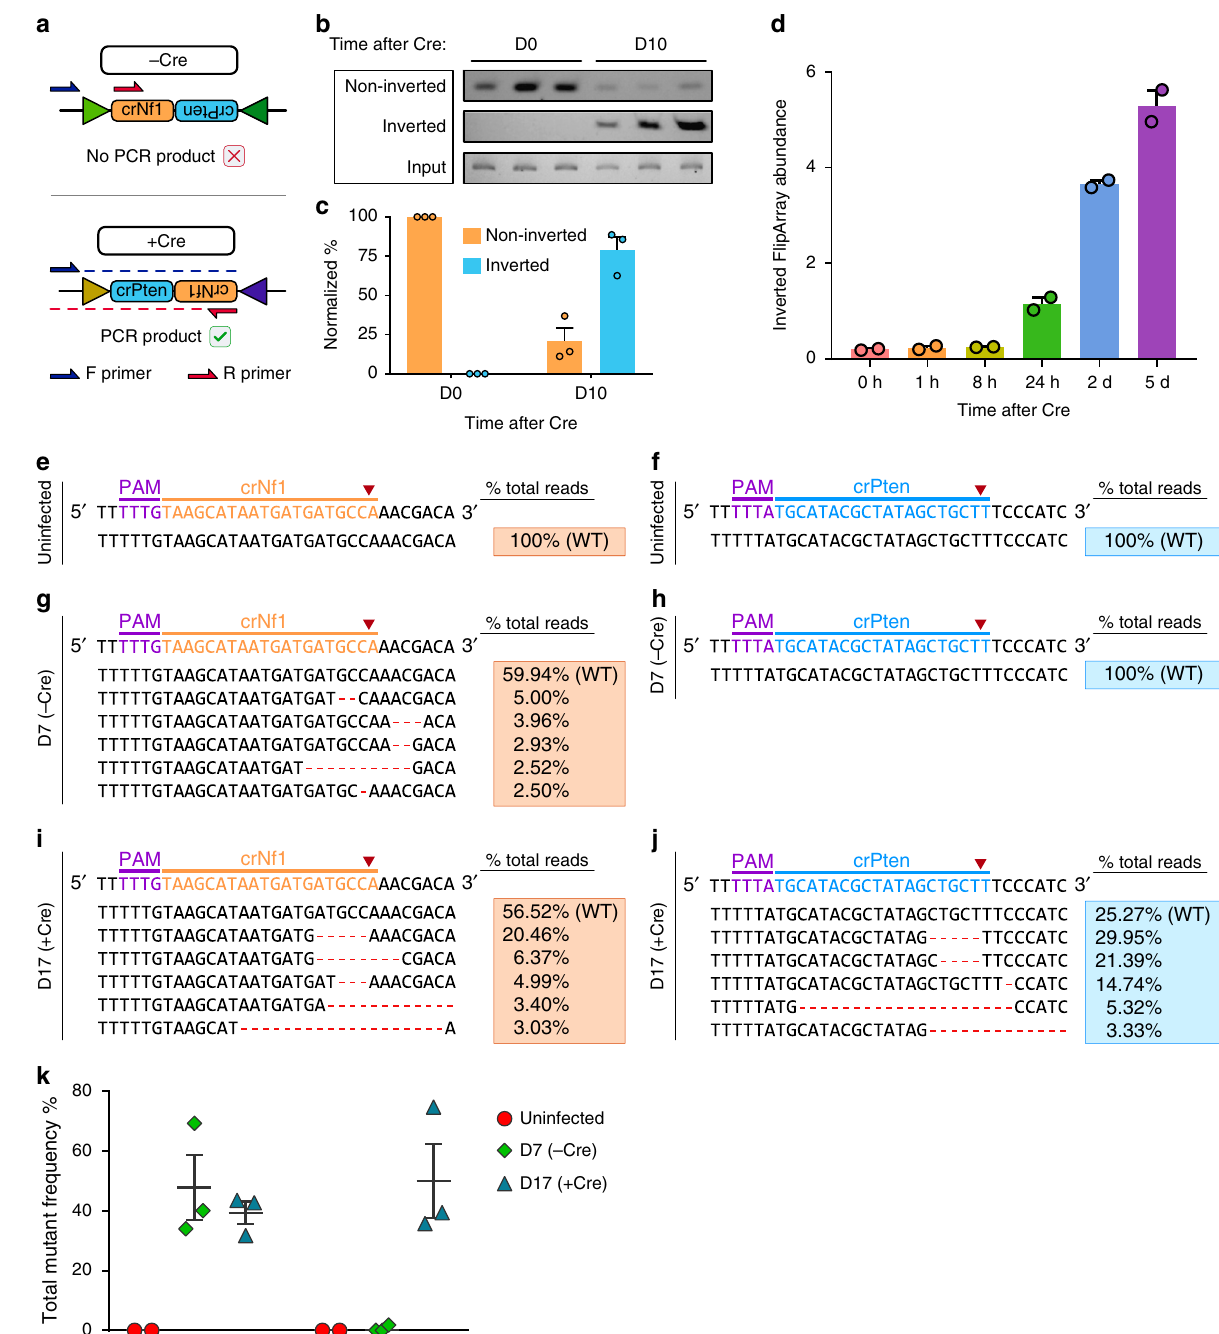
Fig. 2 Inducible sequential mutagenesis in murine cells through Cpf1-Flip. a Schematic for PCR-based detection of Cre-mediated inversion of the crRNA FlipArray (targeting Nf1 and Pten ). b PCR-based detection of non-inverted and inverted FlipArrays at D0 ( n = 3) and D10 ( n = 3) following Cre, along with input control. c Quanti fi cation of gel intensities in b , normalized to input and expressed as a percentage of total FlipArray abundance. d Detection and